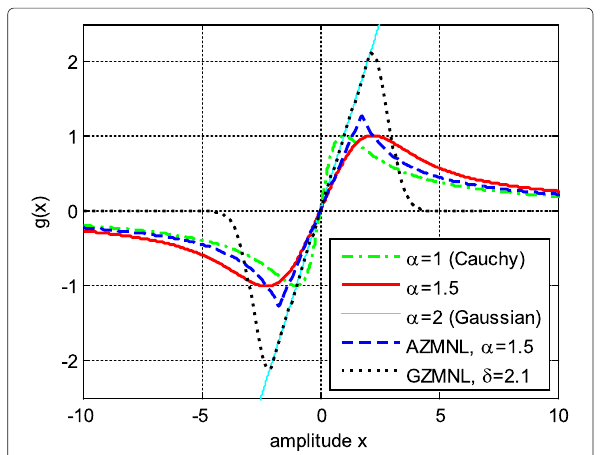
Fig. 1 The LODs for S α S noise and reported ZMNL design [7], for σ =